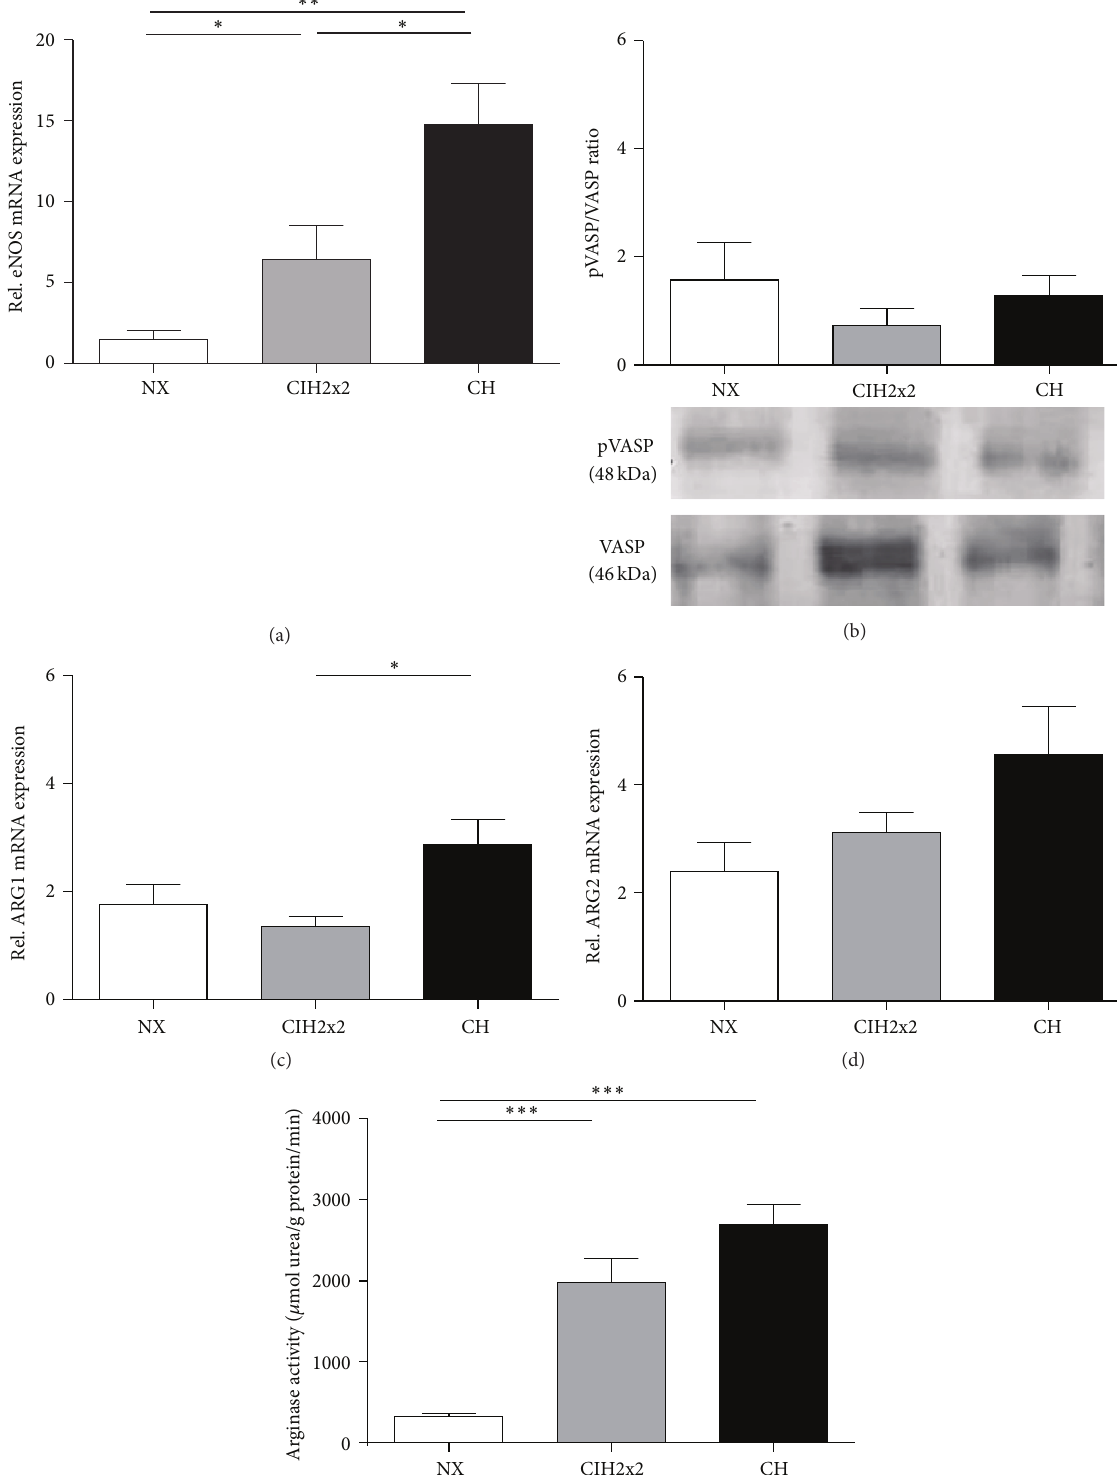
Figure 2: Comparison of (a) mRNA expression of eNOS by qRT-PCR and (b) sGC-dependent bioavailability of NO, expressed as the pVASP/VASP protein ratio. Representative bands on western blots are presented. The substrate availability of NOS, expressed as (c) mRNA expression of arginase isoform I determined by qRT-PCR, (d) mRNA expression of arginase isoform II determined by qRT-PCR, and (e) arginase activity ( 𝜇 mol urea/g protein/min) determined by spectrophotometry in the lungs of rats exposed to normoxia (NX), chronic intermittent hypoxia (CIH2x2), or chronic hypoxia (CH). Values are expressed as means and SE. ∗ 𝑝 < 0.05 ; ∗∗ 𝑝 < 0.01 ; ∗∗∗ 𝑝 < 0.001 ; 𝑛 = 8 in each